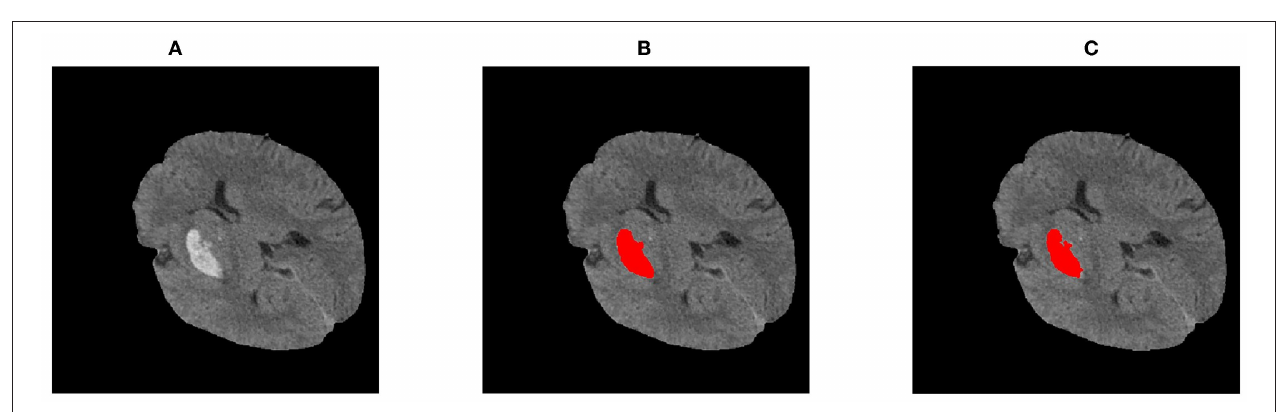
FIGURE 7 | Boxplot of similarity metrics.